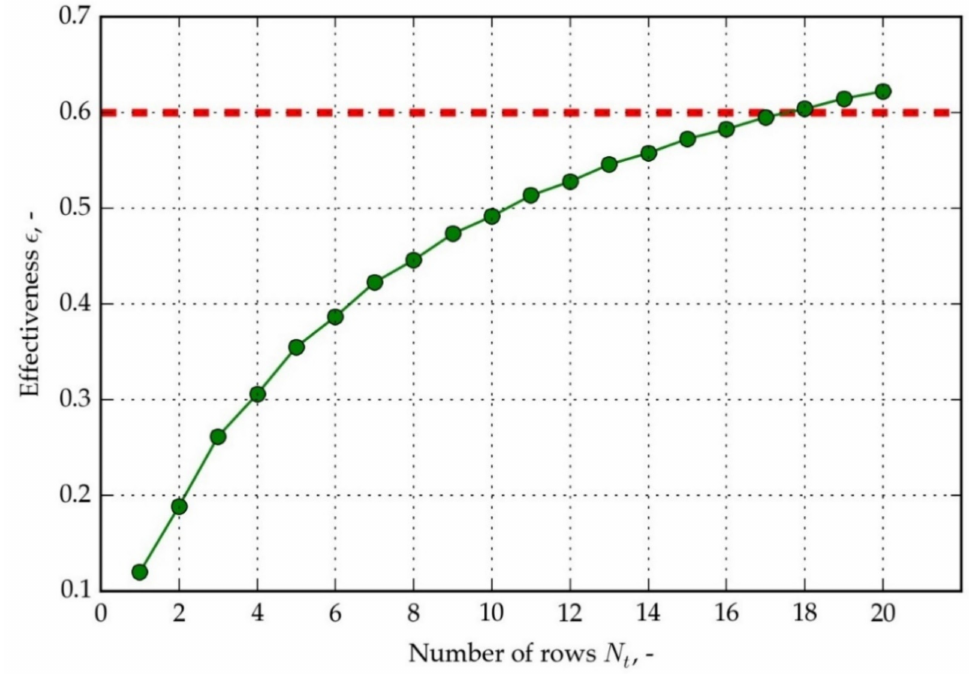
Figure 9. Thermal effectiveness of HPHE as a function of number of rows, for inlet cold air tempera- ture 10 ◦ C and hot air inlet temperature 30 ◦